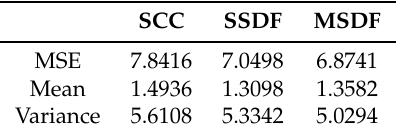
Table 1. Table of MSE, Mean (Bias), and Variance of prediction